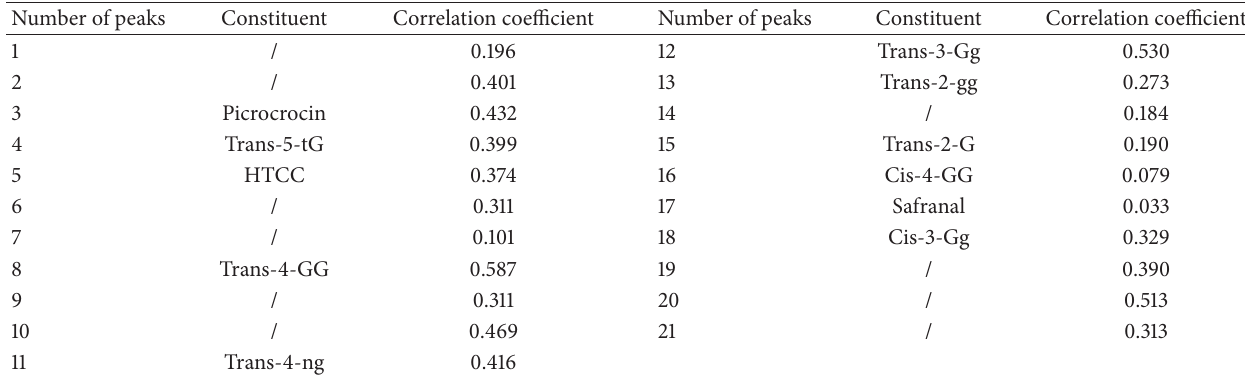
Table 2: The relation of peaks to antioxidant